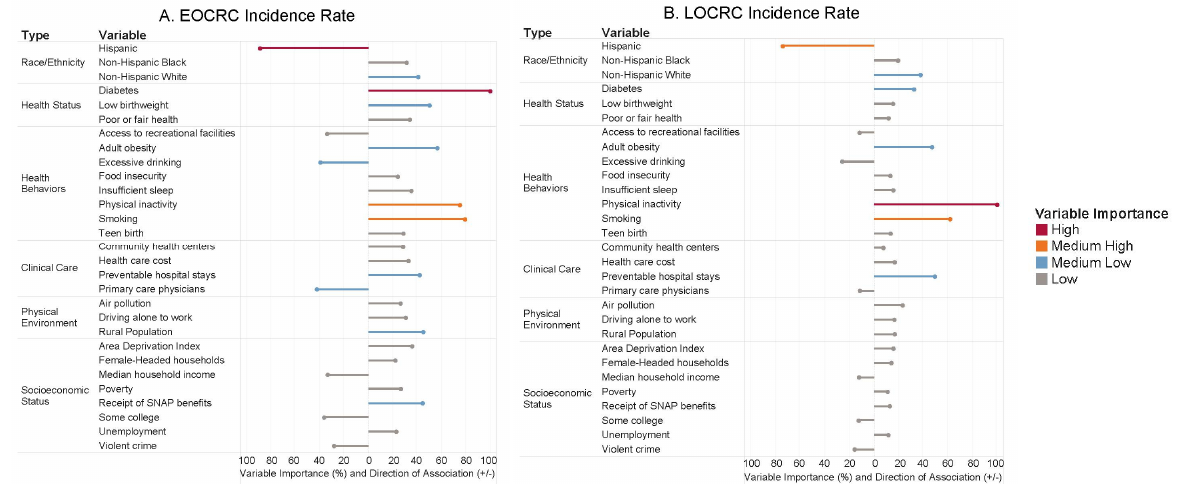
Figure 2. Variable importance and direction of association of risk factors for ( A ) EOCRC incidence rate, and ( B ) LOCRC incidence rate. Notes: (1) The most important variable is set to 100%. The importance of the rest of the variables is scaled relative to the most important variable. (2) Direction of association was determined by a linear correlation coefficient. (3) Categories of variable importance (i.e., high to low) was classified by the Jenks natural breaks method. For race/ethnicity, the Hispanic population predictor had a high VI (ranked second) in the EOCRC model and medium-high VI (ranked second) in the LOCRC model, with a negative association with both outcomes, meaning that both of these diseases were less likely to be in the Hispanic population. The Non-Hispanic Black predictor was positively associated with both EOCRC and LOCR, but their VI was low for both outcomes (20th and 10th, respectively). The Non-Hispanic White predictor was also positively associated with both EOCRC and LOCRC, and their VI was medium-low for both outcomes (11th for EOCRC and sixth for LOCRC).